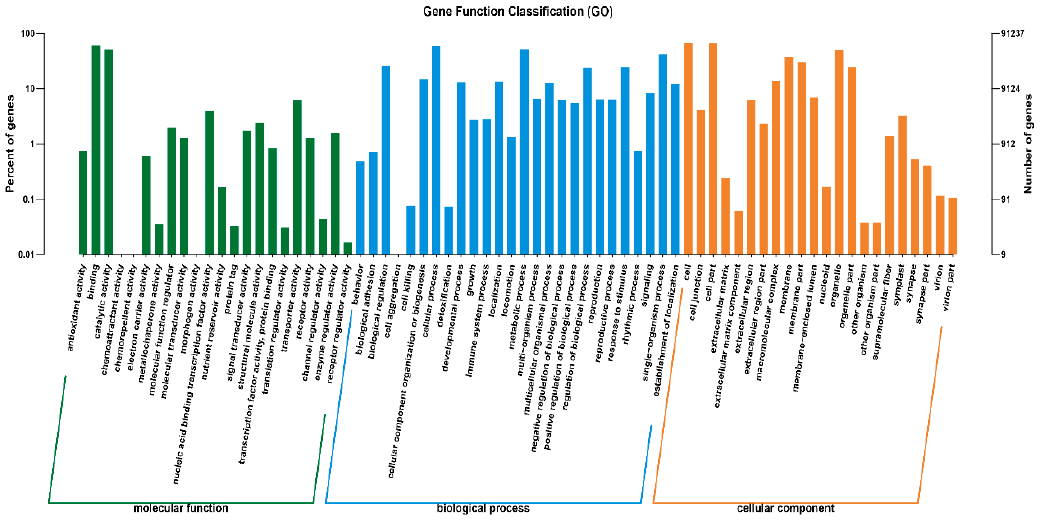
Figure 1. Bar plots of Gene Ontology (GO) classifications of the assembled sequences from the Kentucky Bluegrass transcriptome.